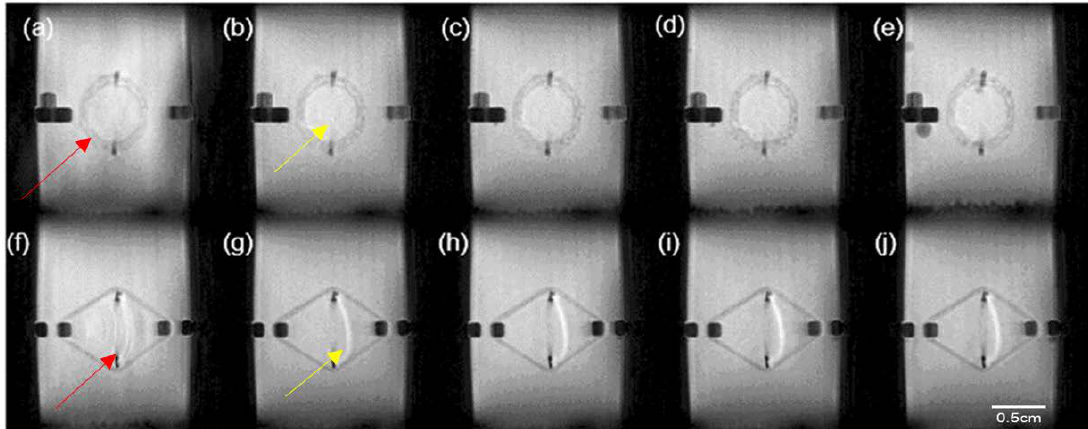
Figure 9. MRI images of the PPP scaffold from the front view at ( a ) 0 h; ( b ) 2 h; ( c ) 4 h; ( d ) 8 h; ( e ) 24 h and from side view at ( f ) 0 h; ( g ) 2 h; ( h ) 4 h; ( i ) 8 h; and ( j ) 24 h, where red arrows depict the PCL scaffold and yellow arrows depict the PVA–PAA hydrogel.